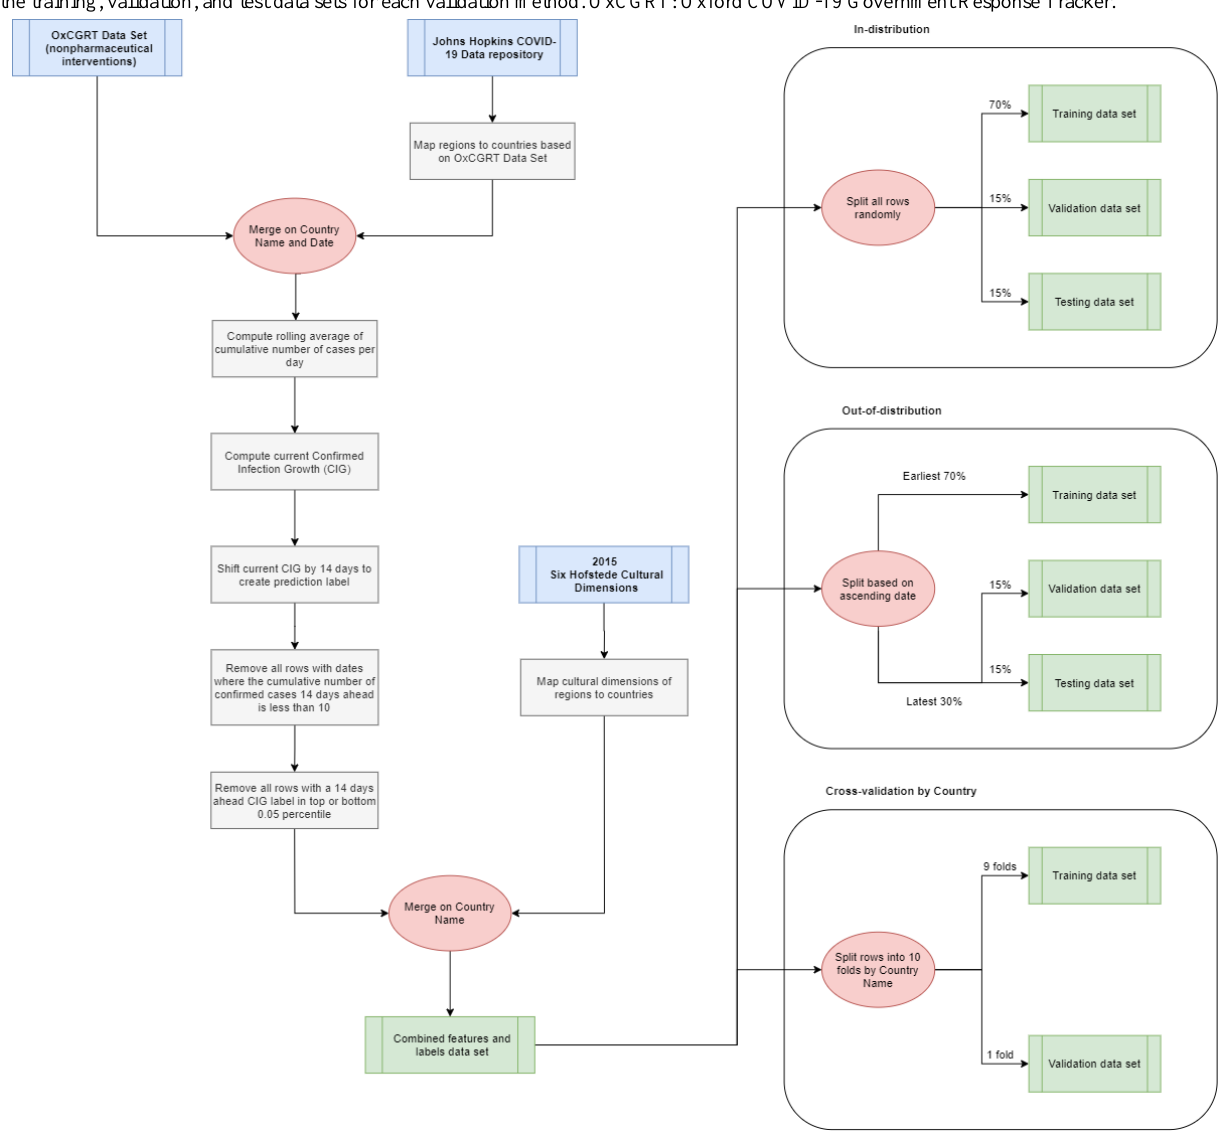
Figure 1. Data preprocessing pipeline from the OxCGRT data set, Johns Hopkins COVID-19 Data Repository, and six Hofstede cultural